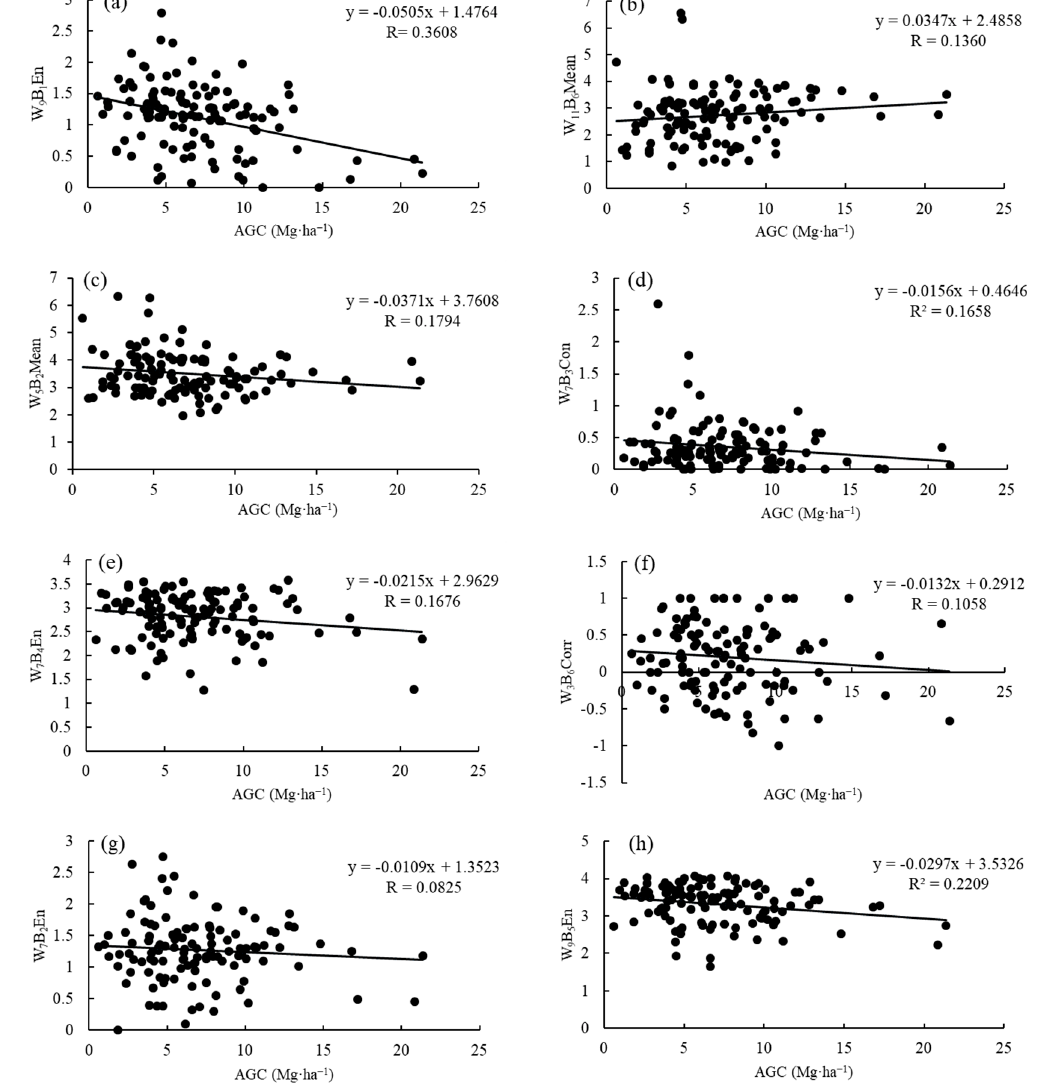
Figure 5. The AGC (Mg · ha − 1 ) versus eight variables derived from the AGC model of 2000: ( a ) AGC versus W 9 B 1 En; ( b ) AGC versus W 11 B 6 Mean; ( c ) AGC versus W 5 B 2 Mean; ( d ) AGC versus W 7 B 3 Con; ( e ) AGC versus W 7 B 4 En; ( f ) AGC versus W 3 B 6 Corr; ( g ) AGC versus W 7 B 2 En; ( h ) AGC versus W 9 B 5 En.